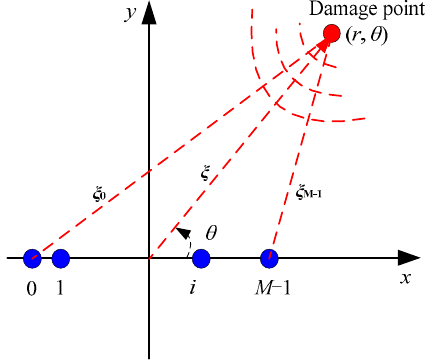
Figure 1. The near-field wavefront diagram of a one-dimensional array.